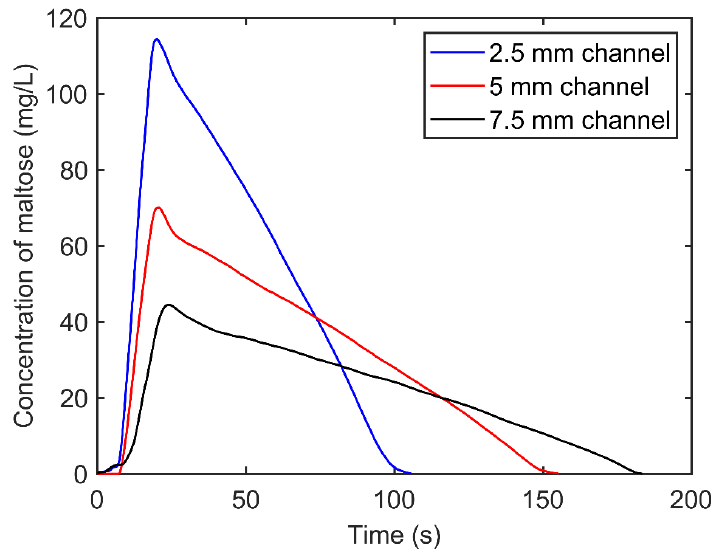
Figure 8. Cleaning curves for constant the Reynolds number of 5000.